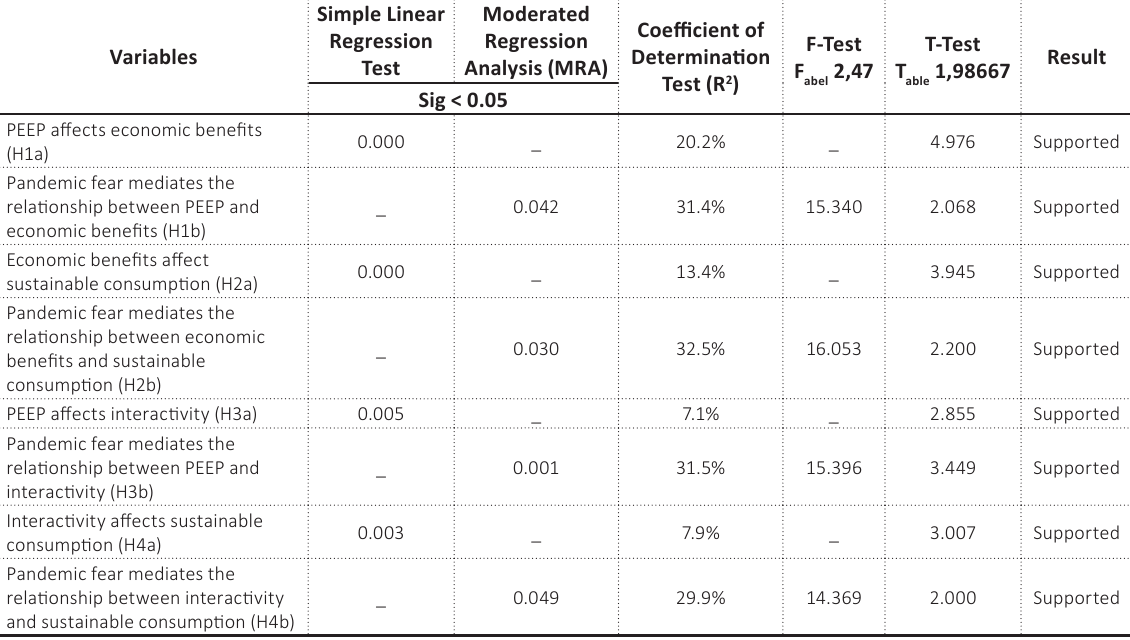
Table 3. Summary of research results